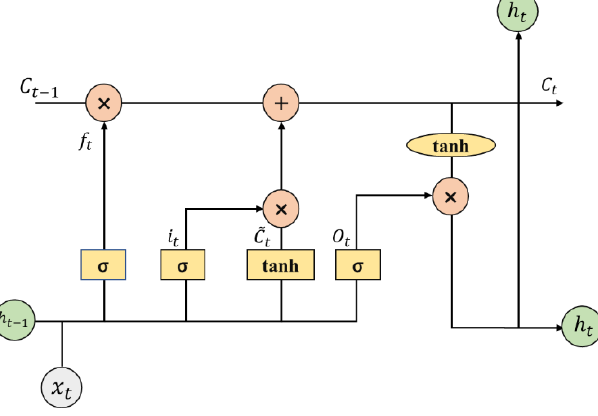
Figure 4. LSTM (long short-term memory) storage unit.